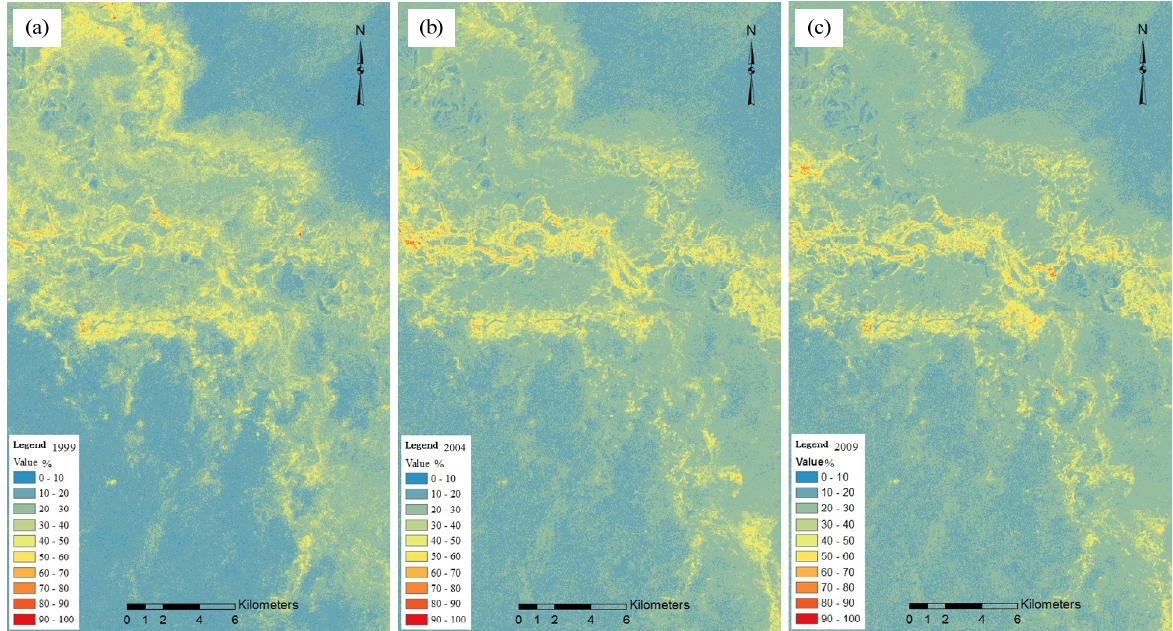
Figure 3. Populus euphratica forest condition of the SNDVI in ( a ) 1999; ( b ) 2004; and ( c ) 2009.